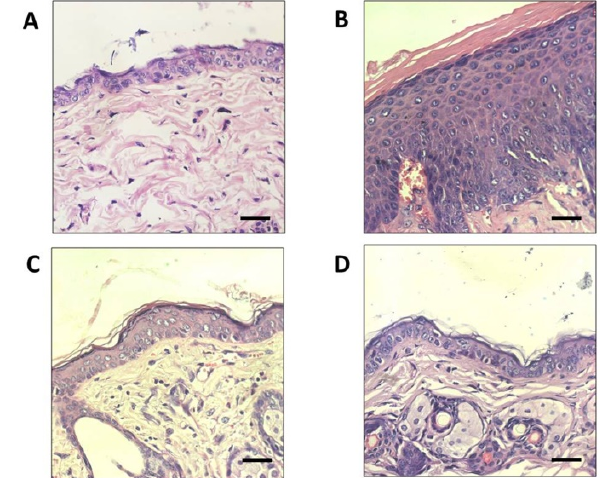
Figure 6. Histological analyses of mice skin irradiated by UV for two hours every day for seven days. ( A ) Control not irradiated with UV (Control − UV) ( B ) Control irradiated with UV (Control + UV) ( C ) Irradiated skin treated with 0.1% SC (SC + UV) ( D ) Irradiated skin treated with commercial product 30 SPF (CP + UV). Skin sections were stained with Hematoxylin and Eosin (H&E). Scale bars: 20 µ